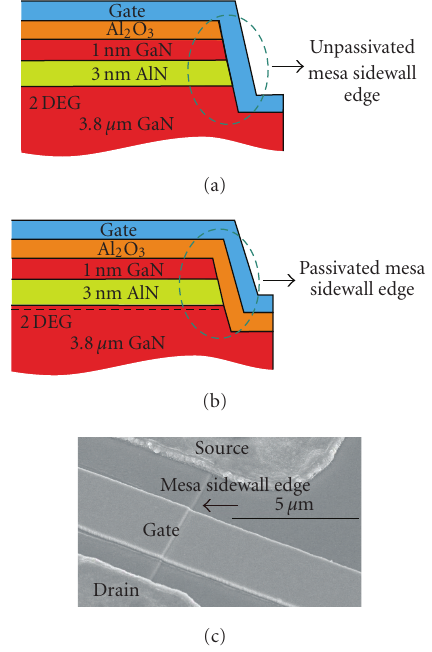
Figure 9: Schematics cross-section of fabricated MOS-HEMT (a) without mesa sidewalls edge passivation, (b) with mesa sidewalls edge passivation, and (c) top-view SEM micrograph of completed two-finger 2.5 μ m gate length